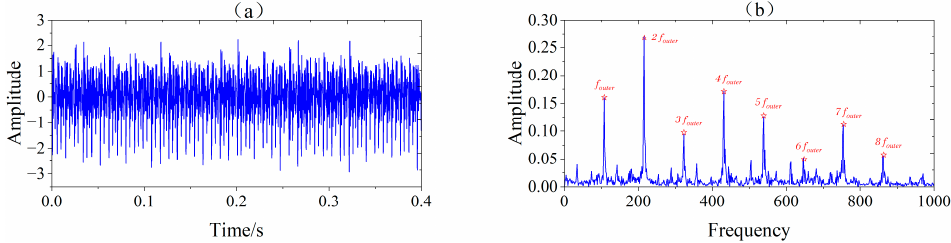
Figure 25. ( a ) The filtered signal from MED by processing the selected PF in the outer race fault signal, and ( b ) the envelope spectrum of filtered signal.